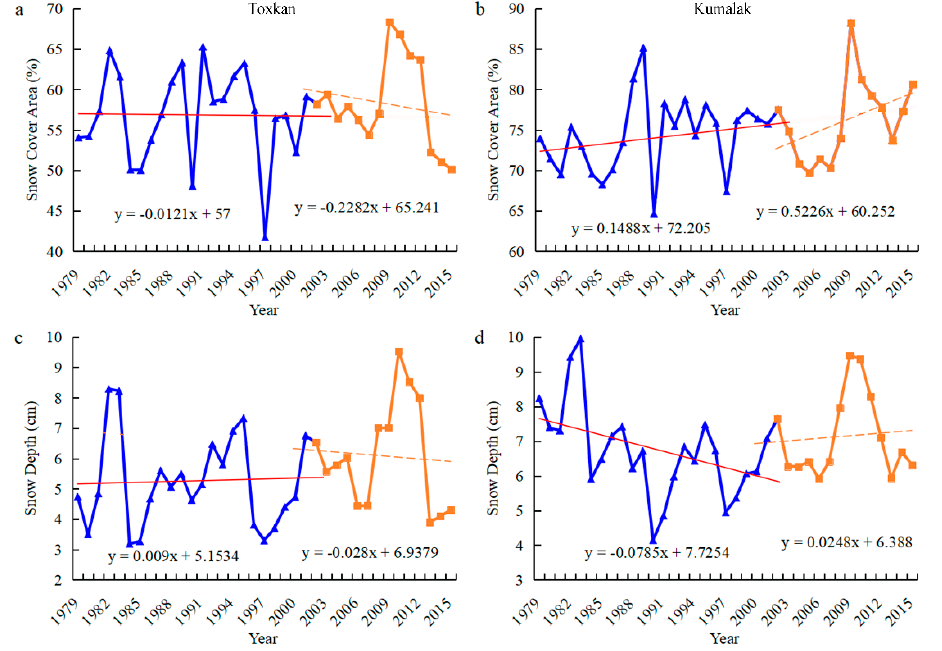
Figure 7. Variation trends in annual average SCA (%) and SD in the Toxkan and Kumalak River catchments from 1979 to 2015. ( a , c ) Variations in SCA and SD in the Toxkan River catchment during 1979–2015; ( b , d ) variations in SCA and SD in the Kumalak River catchment during 1979–2015. Table 4. Seasonal correlation coefficients between SCA, SD, and runoff in the Toxkan River and Kumalak River from 1979–2015.